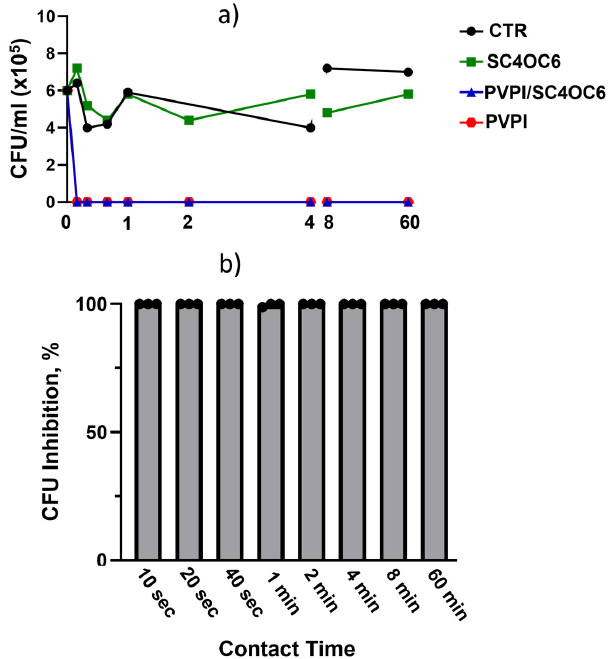
Figure 11. ( a ) Representative time-killing experiment performed against Staphylococcus Epidermidis for the vehicle PBS (CTR), PVPI 0.1%, SC4OC6 (0.25 mg/mL), and PVPI/SC4OC6; ( b ) inhibition (%) of the bacterial cell viability (3 time-killing experiments) by PVPI/SC4OC6. Statistical analysis (Two-Way ANOVA) of time-killing assay for PVPI/SC4OC6 vs. SC4OC6: 10, 20, and 40 s, 1 and 2 min, p < 0.01; 4 and 8 min p < 0.001; 60 min p < 0.05.